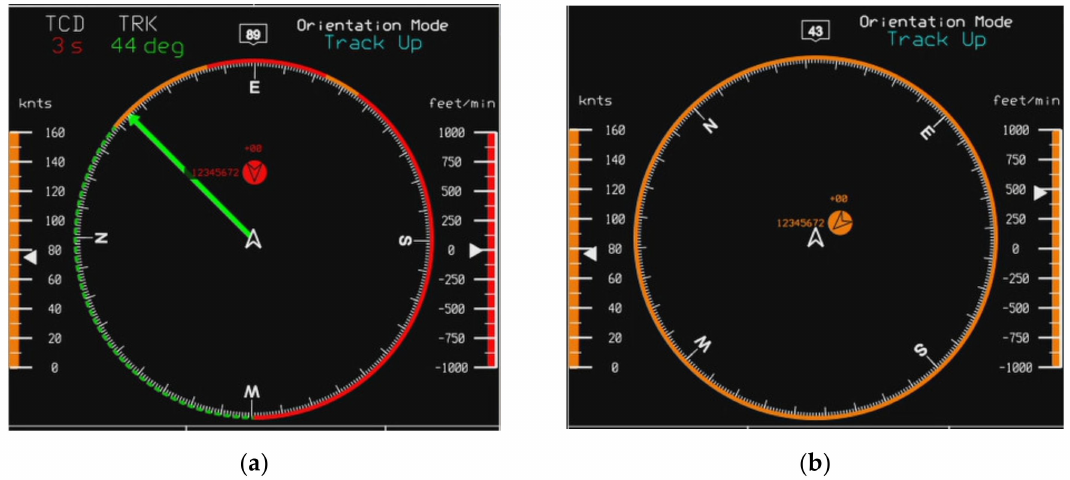
Figure 17. The CDTI before ( a ) and after ( b ) the avoidance